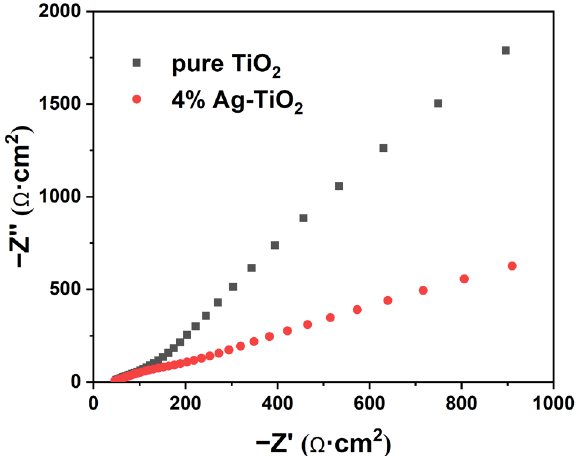
Figure 10. EIS Nyquist plots of pure TiO 2 and 4%Ag-TiO 2 .